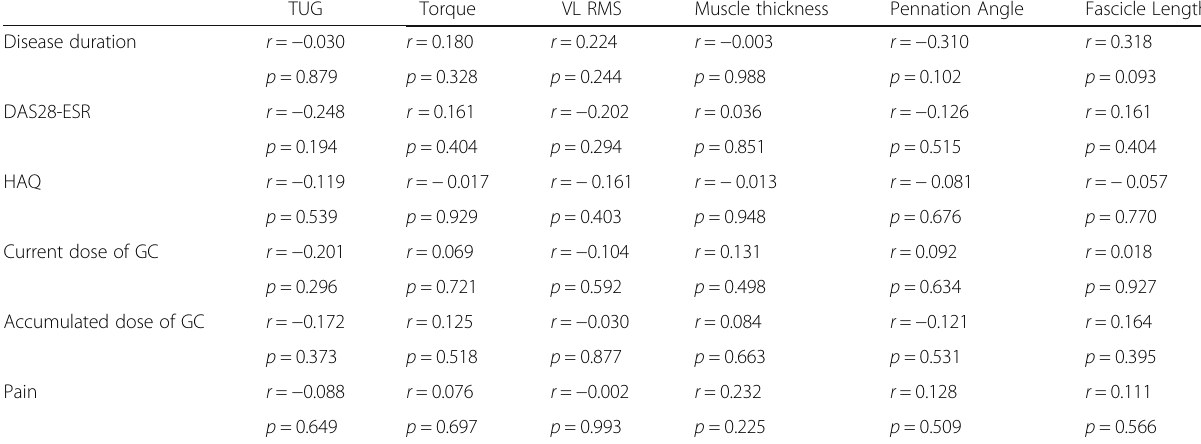
Table 3 RA patients association between neuromuscular outcomes and clinical characteristics controlled by physical activity level TUG Torque VL RMS Muscle thickness Pennation Angle Fascicle Length Disease